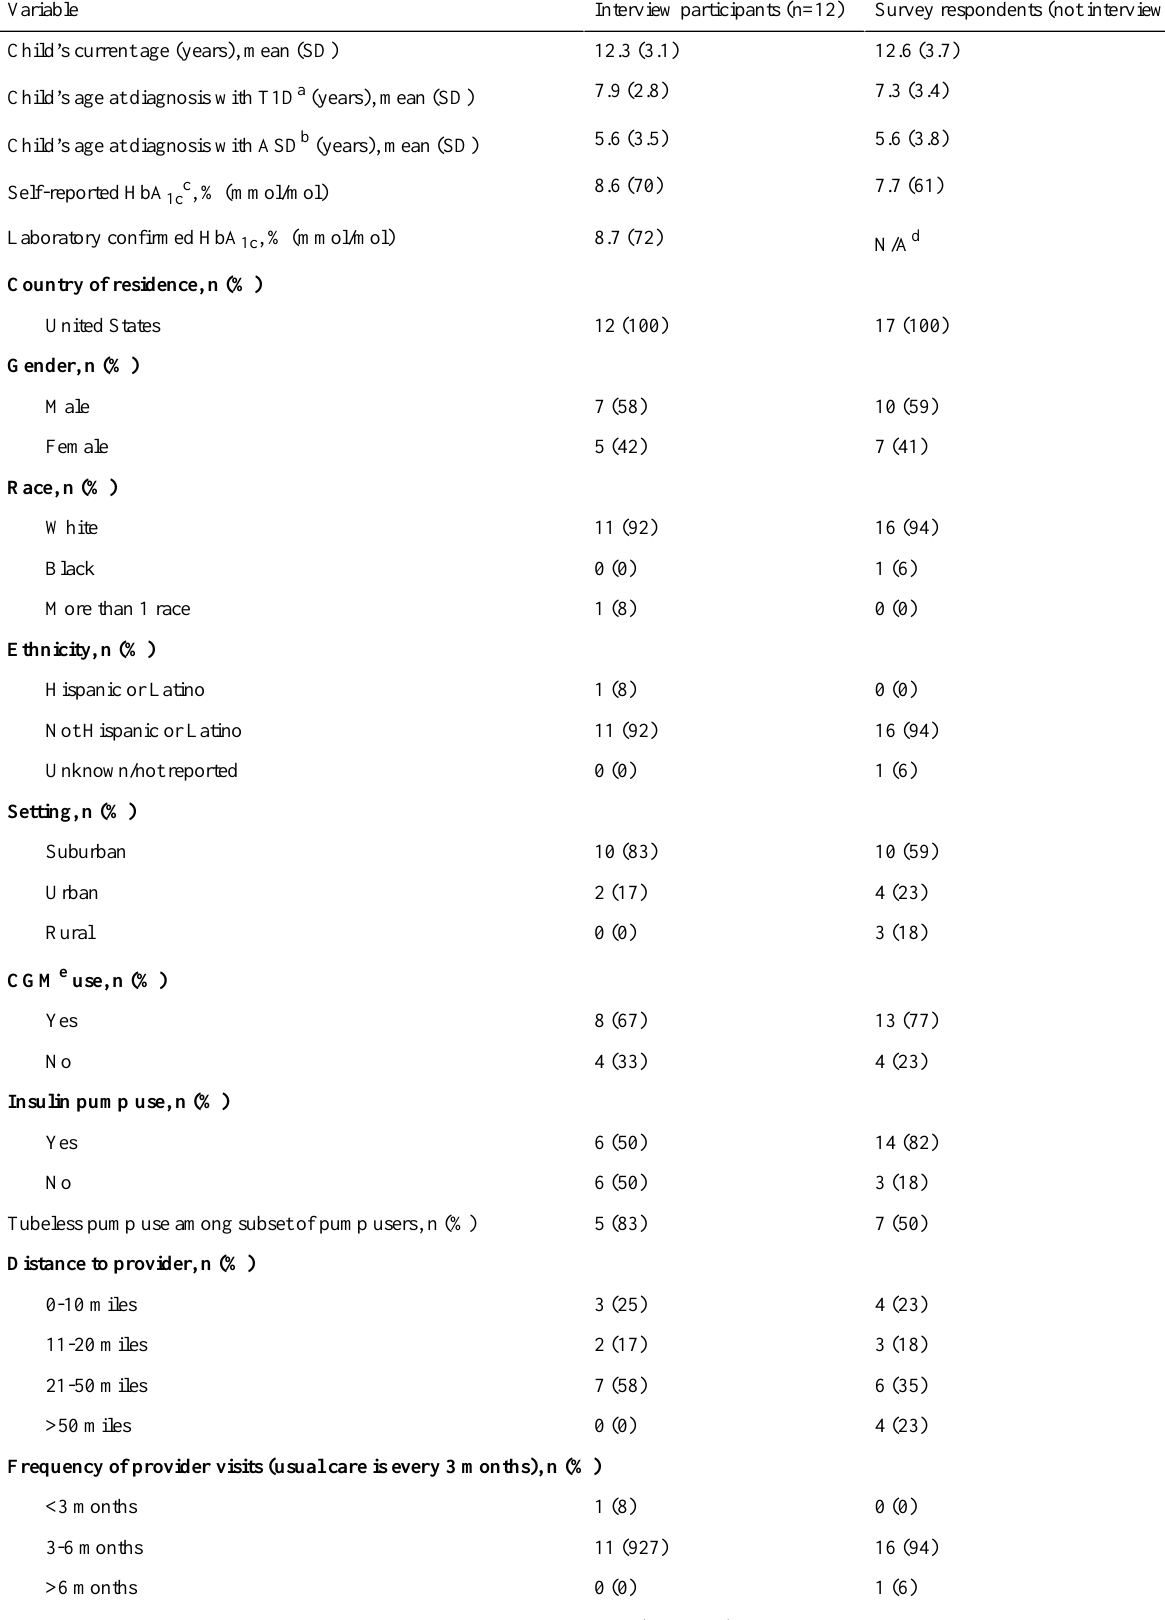
Table 2. Phase 2 participant